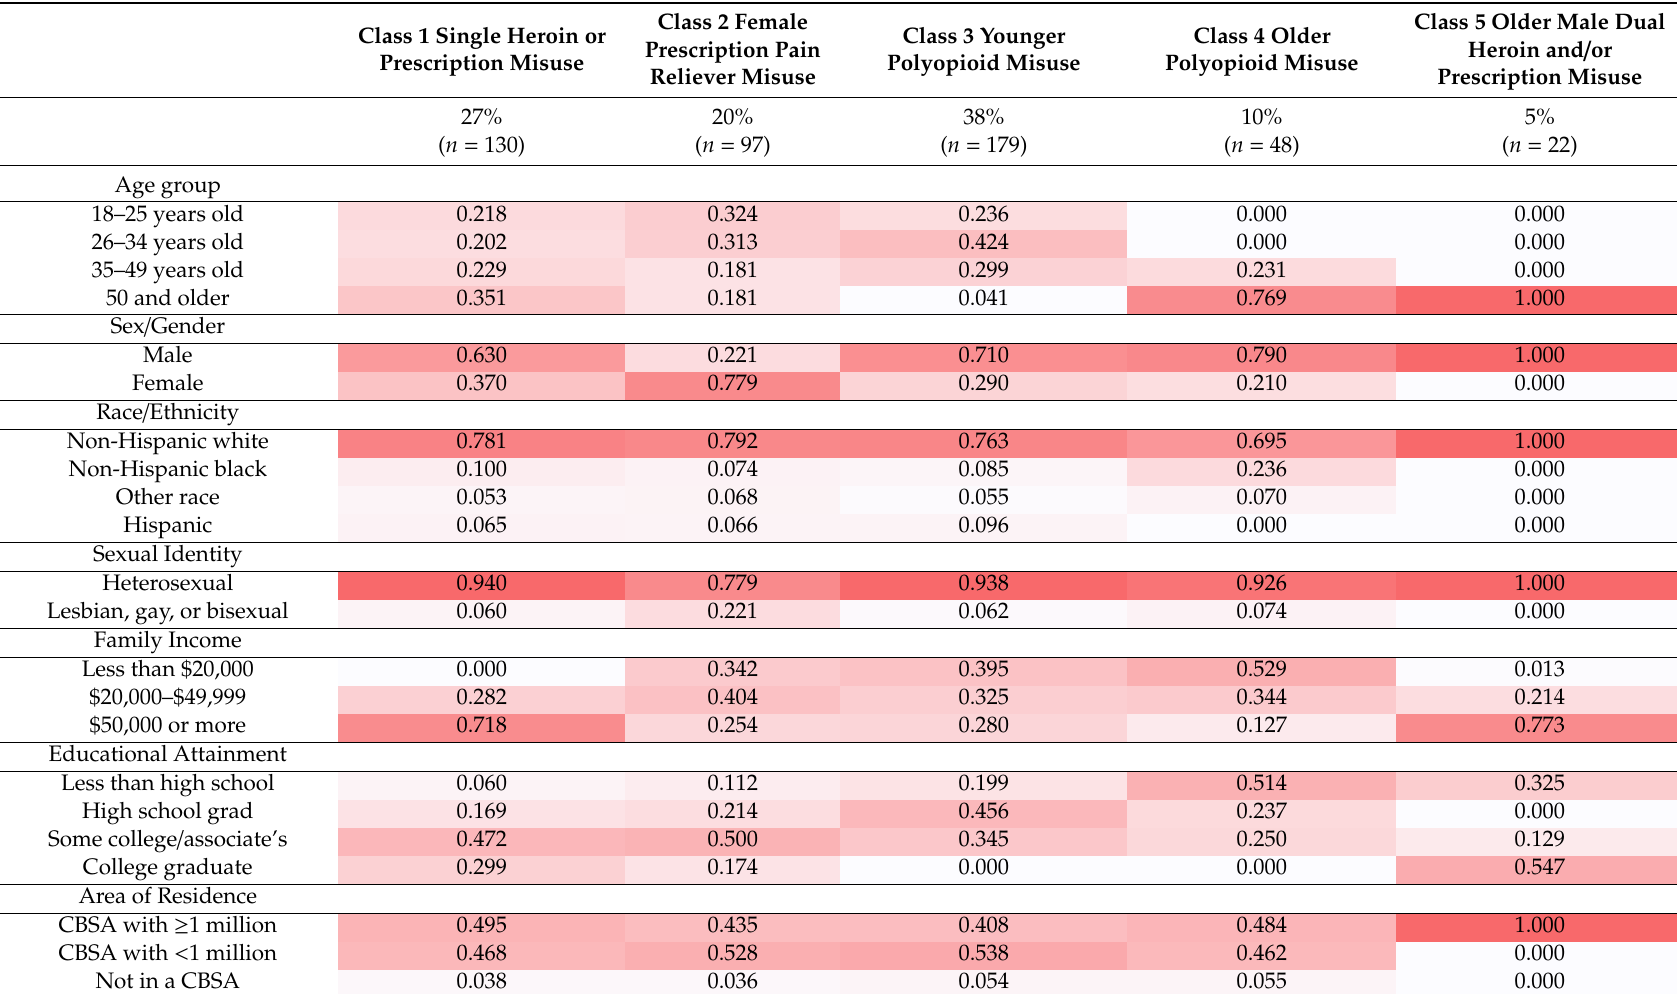
Table 2. Five-class solution conditional probabilities from latent class analysis ( n = 476; Weighted n =